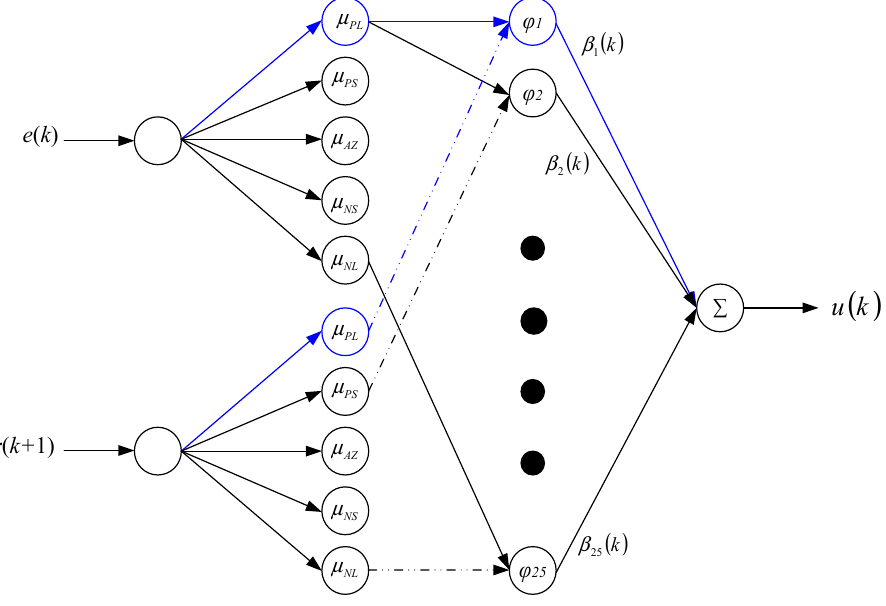
Figure 3. Multi-input Fuzzy Rule Emulated Network (MiFREN) Controller with an IF-THEN